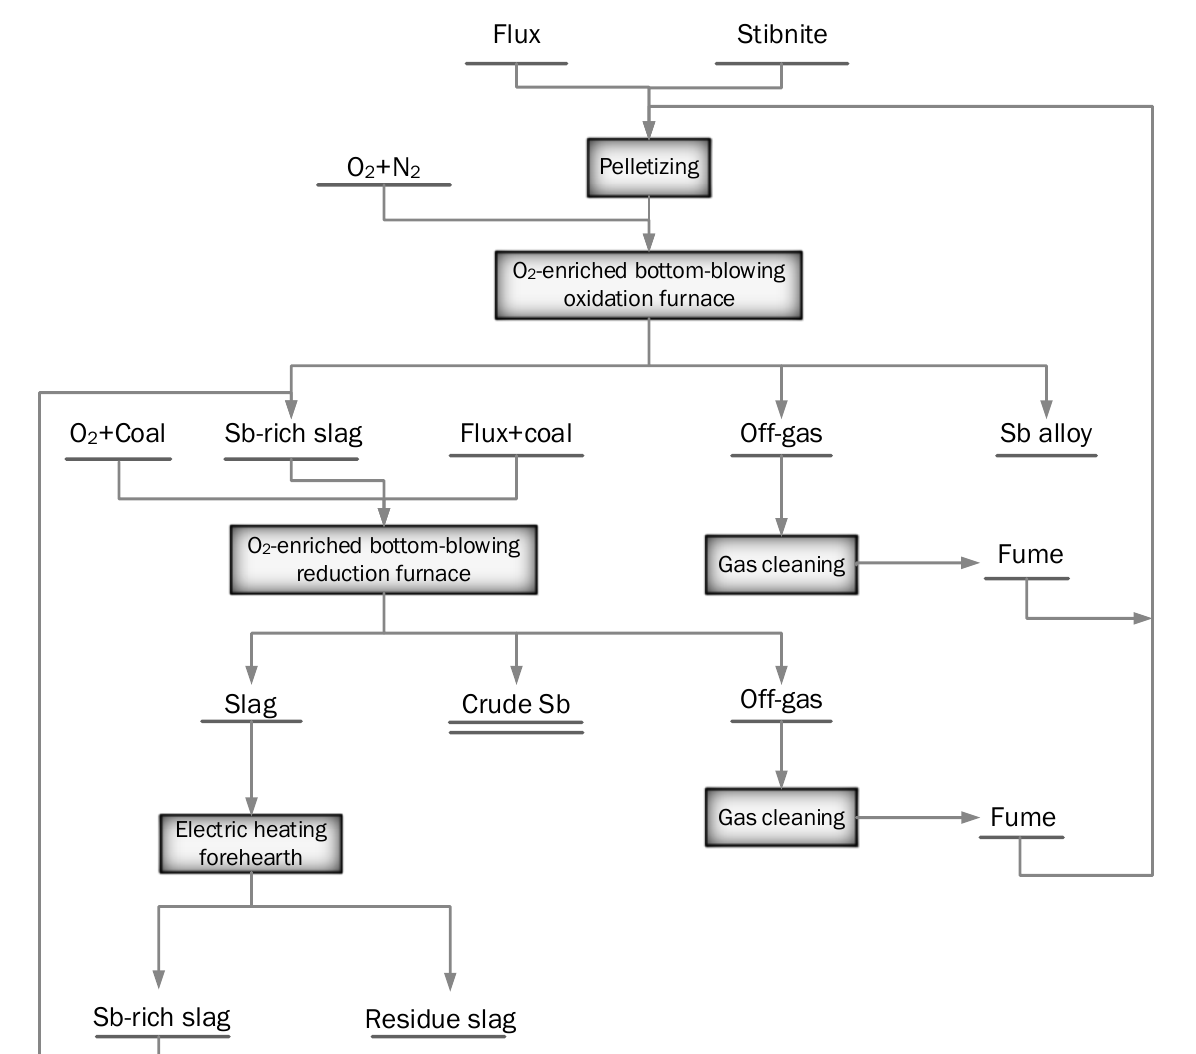
Figure 14. Schematic flowsheet of antimony production from stibnite via oxygen-enriched bottom- blowing and direct reduction (adapted from [62]).